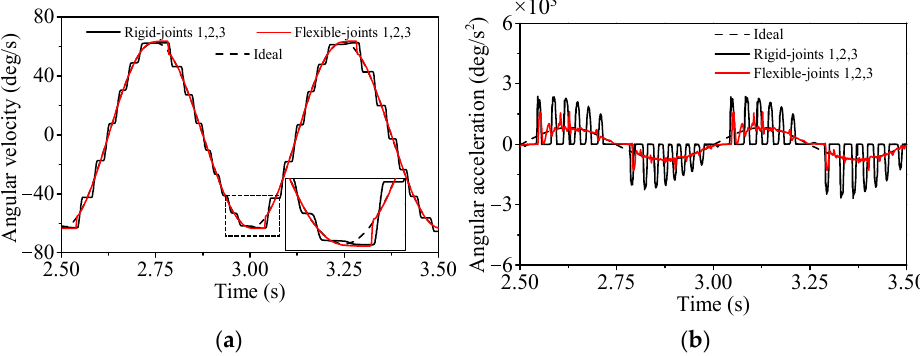
Figure 21. Effects of clearances at joints 1, 2, and 3 when considering the flexibility of the auxiliary rod: ( a ) angular velocity; ( b ) angular